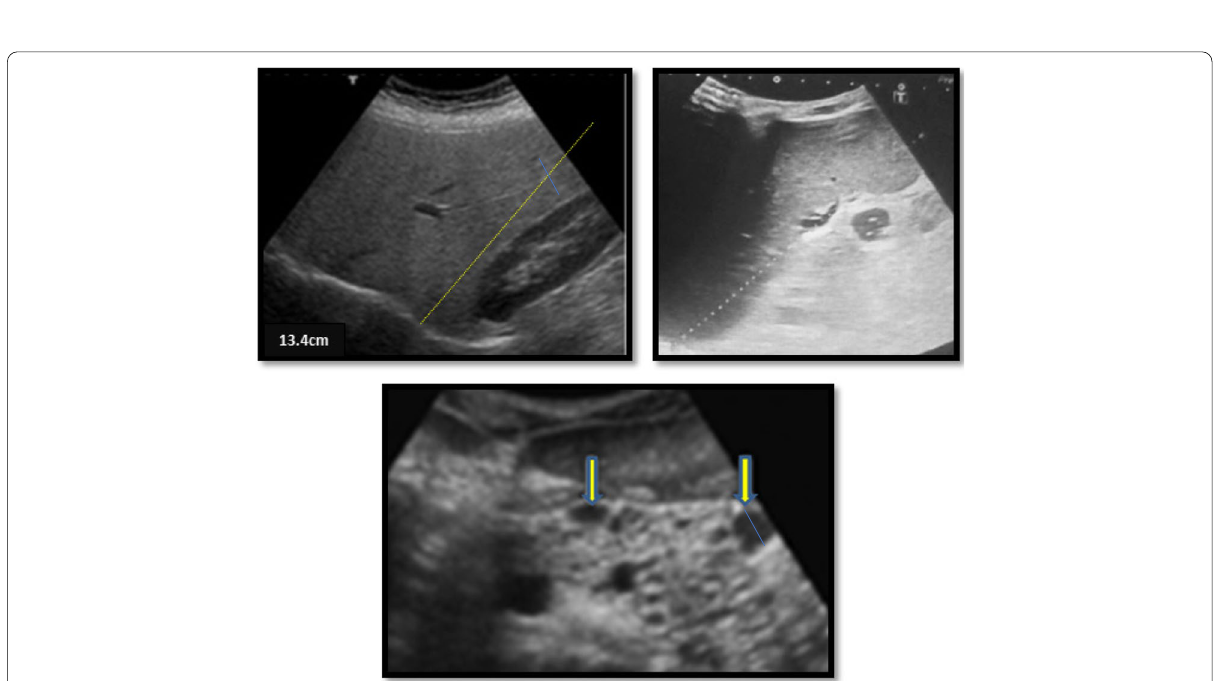
Fig. 3 A child known to have cystic fibrosis. He was complaining of chronic cough, vomiting, recurrent abdominal pain, and steatorrhea improving on pancreatic enzyme replacement therapy. His labs are as follows: ALT, 15; AST, 38; Na, 139; K, 4.1; and random blood glucose, 92. Ultrasound of the abdomen shows fatty echogenic liver parenchyma with hepatomegaly measuring about 13.4 cm, splenomegaly measuring 12.9 cm, and increased pancreatic echogenicity with multiple variable-sized cysts measuring up to 20 mm (pancreatic lipomatosis and cystosis,